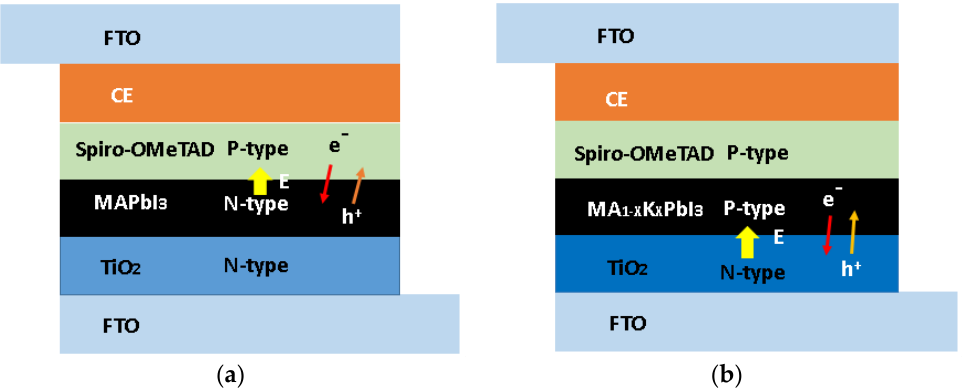
Figure 8. The un-doped and K + doped hetero-junction perovskite device structure. ( a ) The un-doped perovskite device structure; ( b ) the K + doping perovskite device structure. E: built-in electric field.